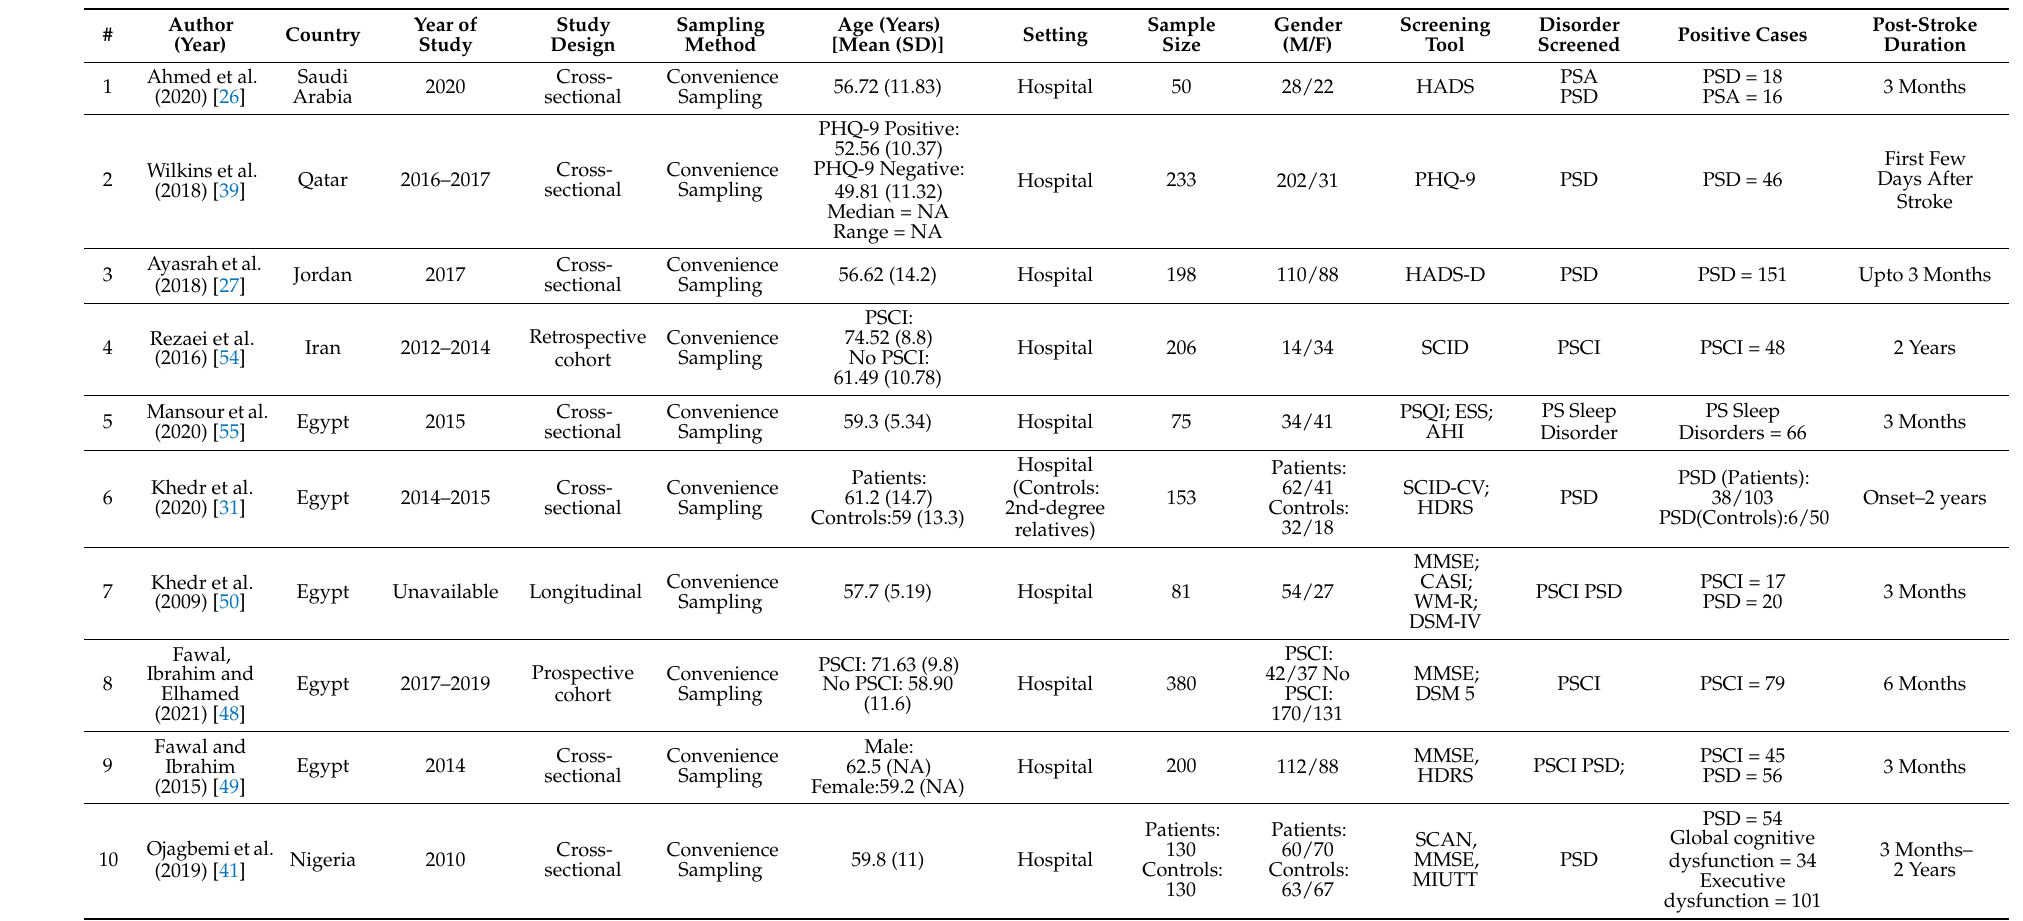
Table 2. Characteristics of the studies included for systematic